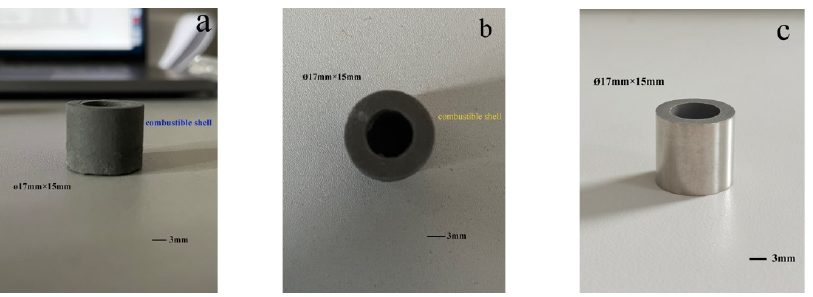
Figure 2. The shell of the illuminant candle: ( a ) shell main view; ( b ) top view of shell; ( c ) structural of low-carbon steel illuminating candle.